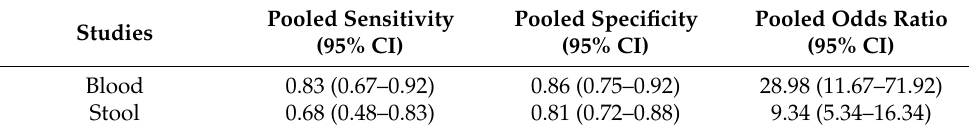
Table 3. Pooled diagnostic performance of miR-92a based on blood and stool sample types.